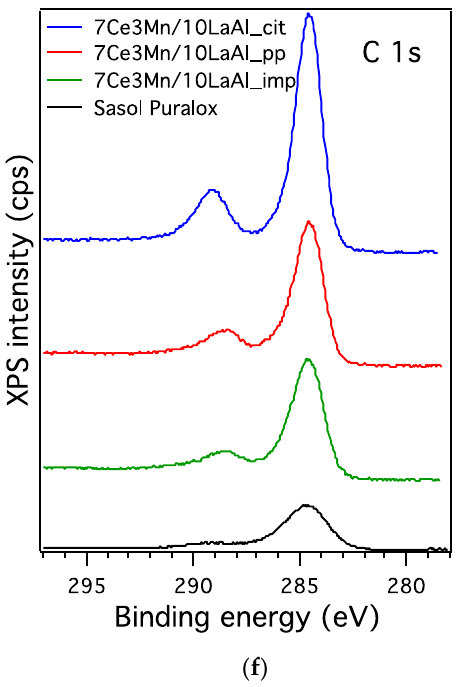
Figure 7. The high-resolution XP spectra of lanthanum-modified alumina supported cerium–manganese mixed oxides samples in the: ( a ) Ce 3d, ( b ) O 1s, ( c ) Mn 3s, ( d ) Al 2p, ( e ) La 3d and ( f ) C 1s high resolution regions.